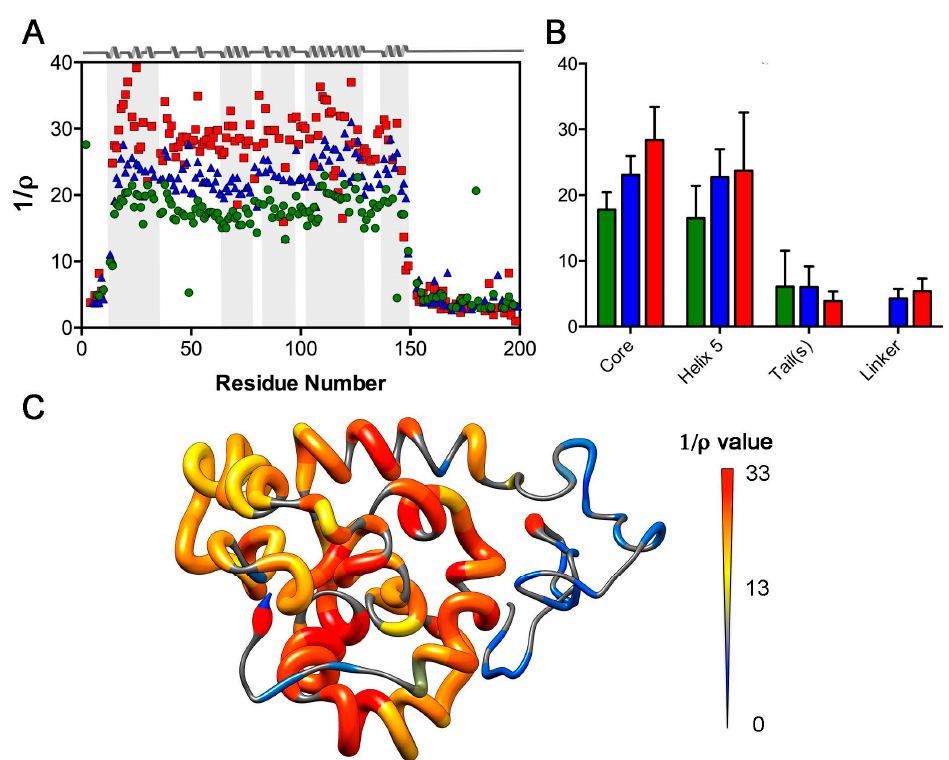
Figure 5. Inverse of ρ ratio of T 1 ’ to T 2 ’ (relaxation times modified to remove high-frequency components of spectral density) as defined by Fushman et al [17]. ( A ) Plotted as a function of residue (green circles: W 1 ; blue triangles: W 2-1 , red squares: W 2-2 ) with secondary structuring of the W unit depicted on the basis of PDB entry 2MU3 [19] using grey shading to delineate each helical segment ( B ) bar graphs for mean (green: W 1 ; blue: W 2-1 , red: W 2-2 ; error bars: standard deviation) over key W unit regions. These were specifically defined as the core (residues 12–149 (W 1 , W 2-1 ) and 212–349 (W 2-2 )), linker (residues 150–211 from W 2-1 and W 2-2 ), tails (W 1 : residues 1–11 and 150–199; W 2 : residues 1–11 and 350–400), and helix 5 (residues 135–149 (W 1 , W 2-1 ) and 335–349 (W 2-2 )); and ( C ) plotted for W 1 on the lowest-energy NMR ensemble member of PDB entry 2MU3 [19], with both backbone thickness and colour varied as a function of 1/ ρ , as indicated.